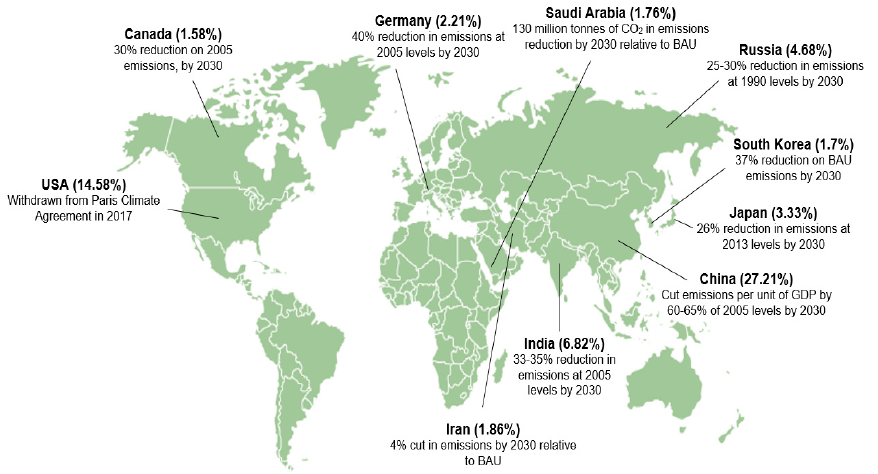
Figure 1. Top 10 global CO 2 emitters and the target in the Paris Agreement [17].